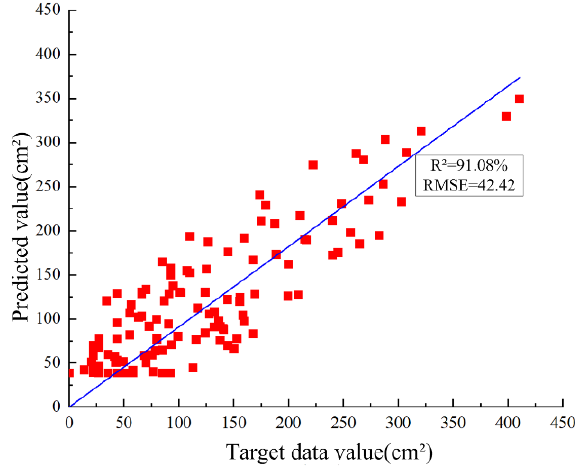
Figure 16. Relationship between the real and predicted values of PLSR test set.